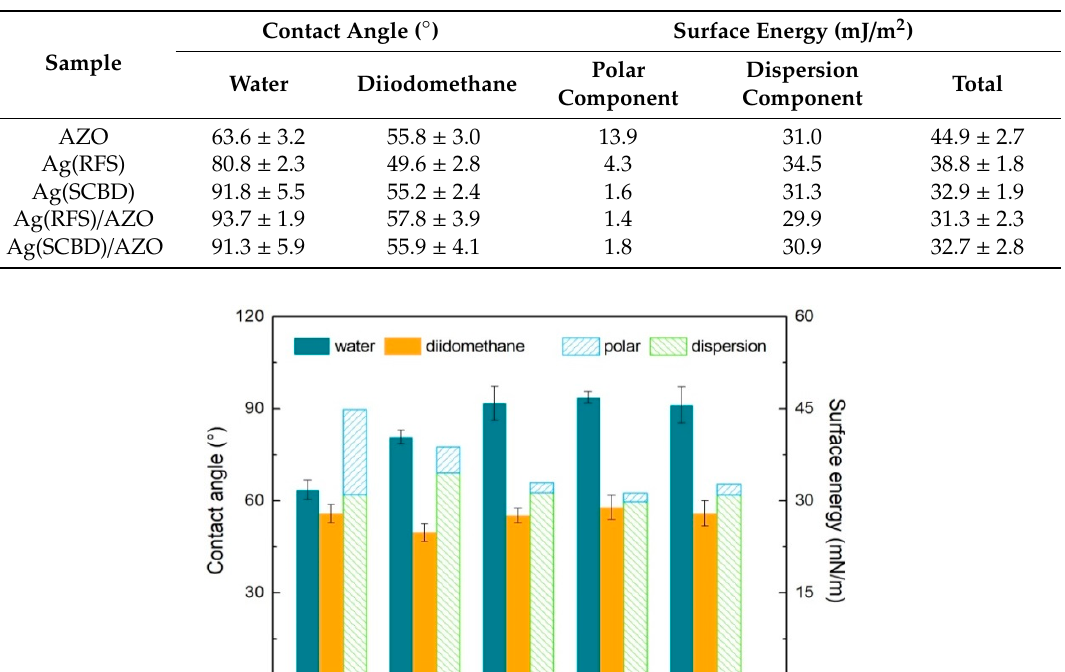
Table 2. Contact angles of water and diiodomethane and surface energy values for coatings deposited on PLA.